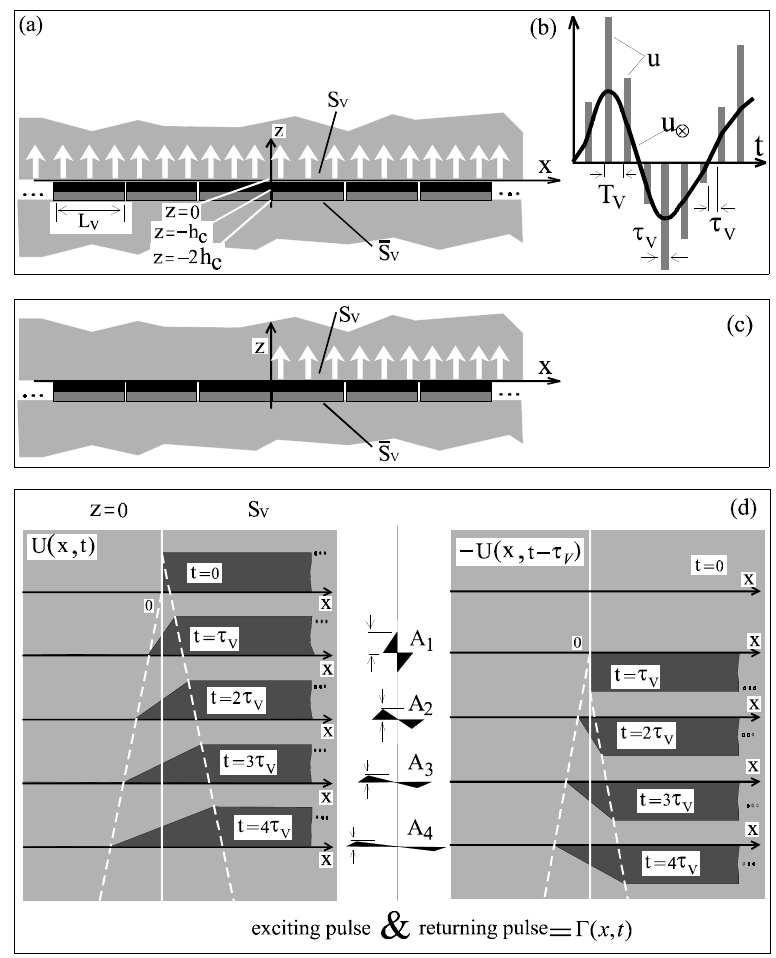
Figure 9. Infinite plane array, formed from a lot of sources of Huygens' (strip-like) pistons. One-dimensional (a) synthesis (in accordance with algorithm (15)) of desired spatially uniform DNOD u ( t ) (b) by sequence p ( t ) pressure pulses (of duration τ ⊗ period τ ) of uniformly distributed pressure blows, applied to boundary z = 0. Step-like V excitation of plane array (c): transient deformations of the boundary z = 0, caused by the first two pulses of pressure (white arrow), applied to the half-plane x ≥ 0